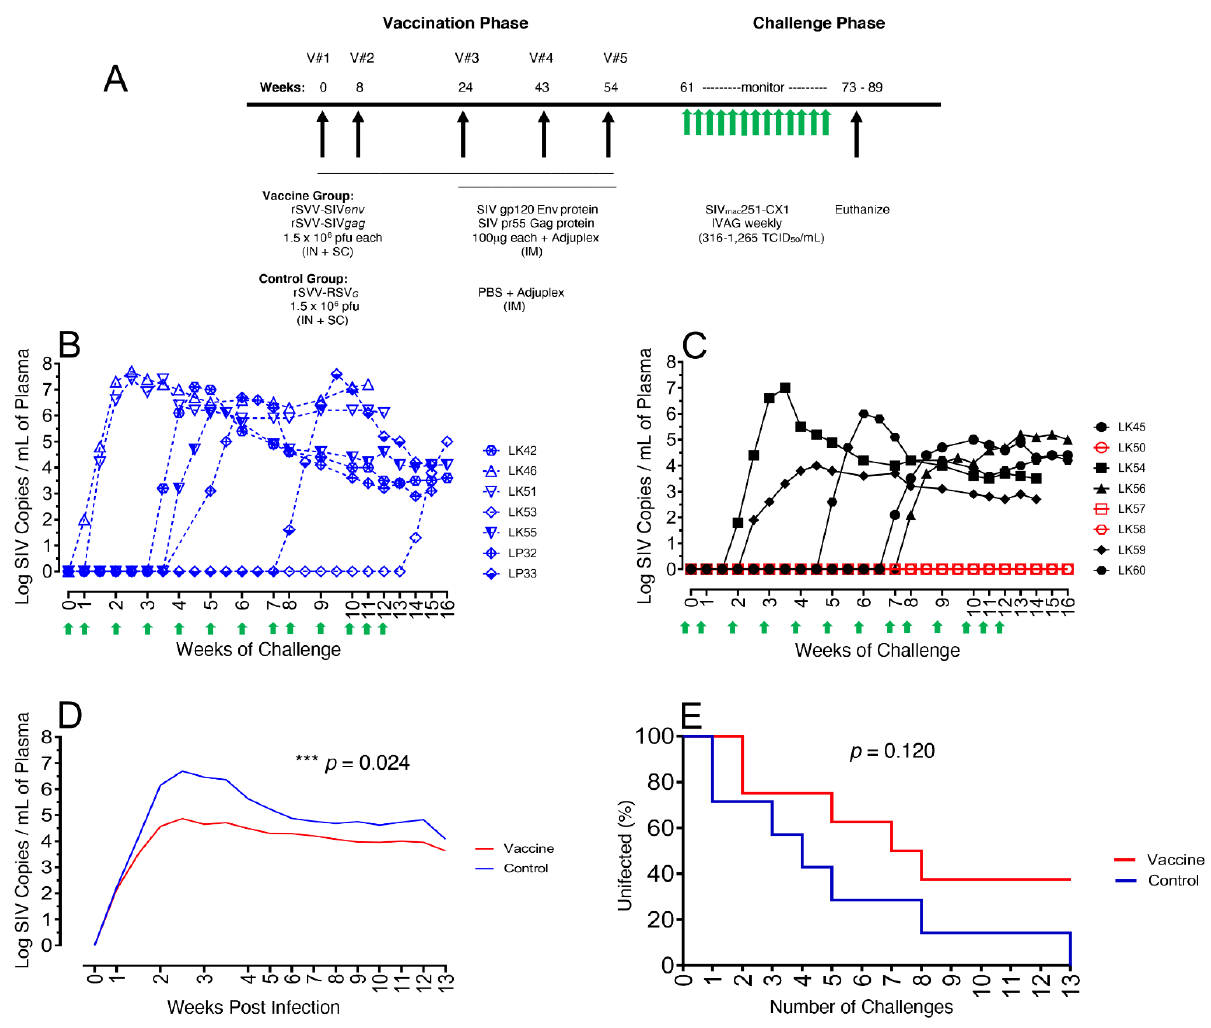
Figure 1. Study design and post infection SIV plasma viral loads. ( A ) Two groups of macaques (RMs) were immunized with either rSVV-SIVenv/gag (vaccine group, n = 8) expressing gag and